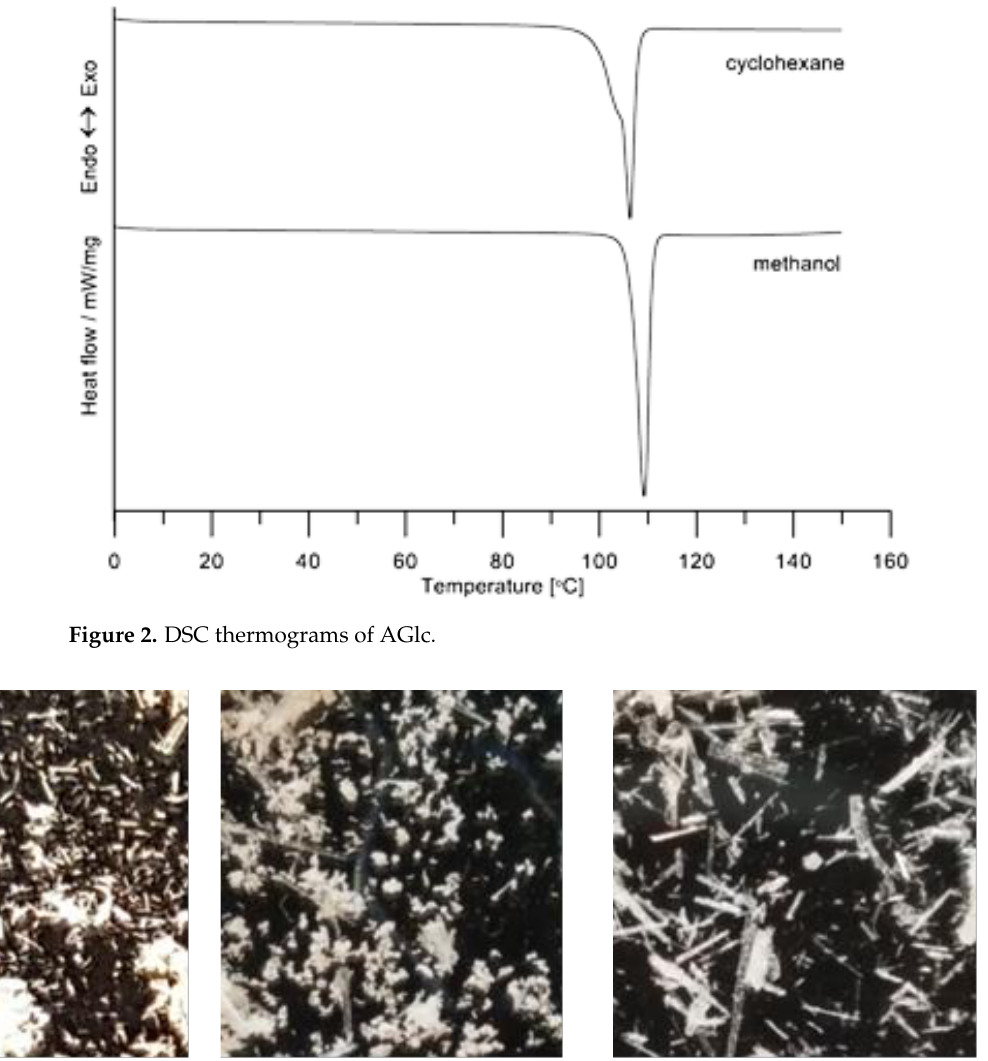
Figure 2. DSC thermograms of AGlc.